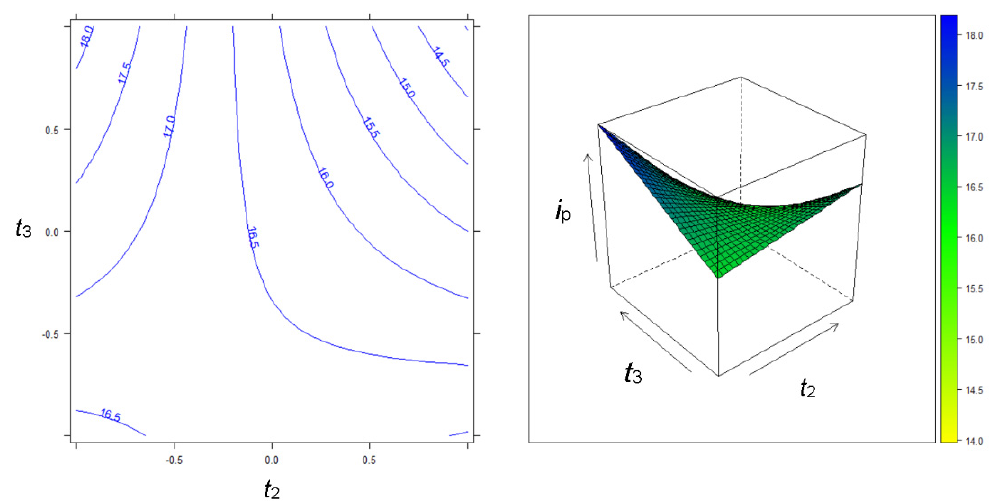
Figure 2. Experimental design to optimize the reaction times of the two Figure 2. the best answers (i.e., highest current peak) were obtained when t 2 was taken to its level − 1 (90 min) while t 3 to the level +1 (120 min).